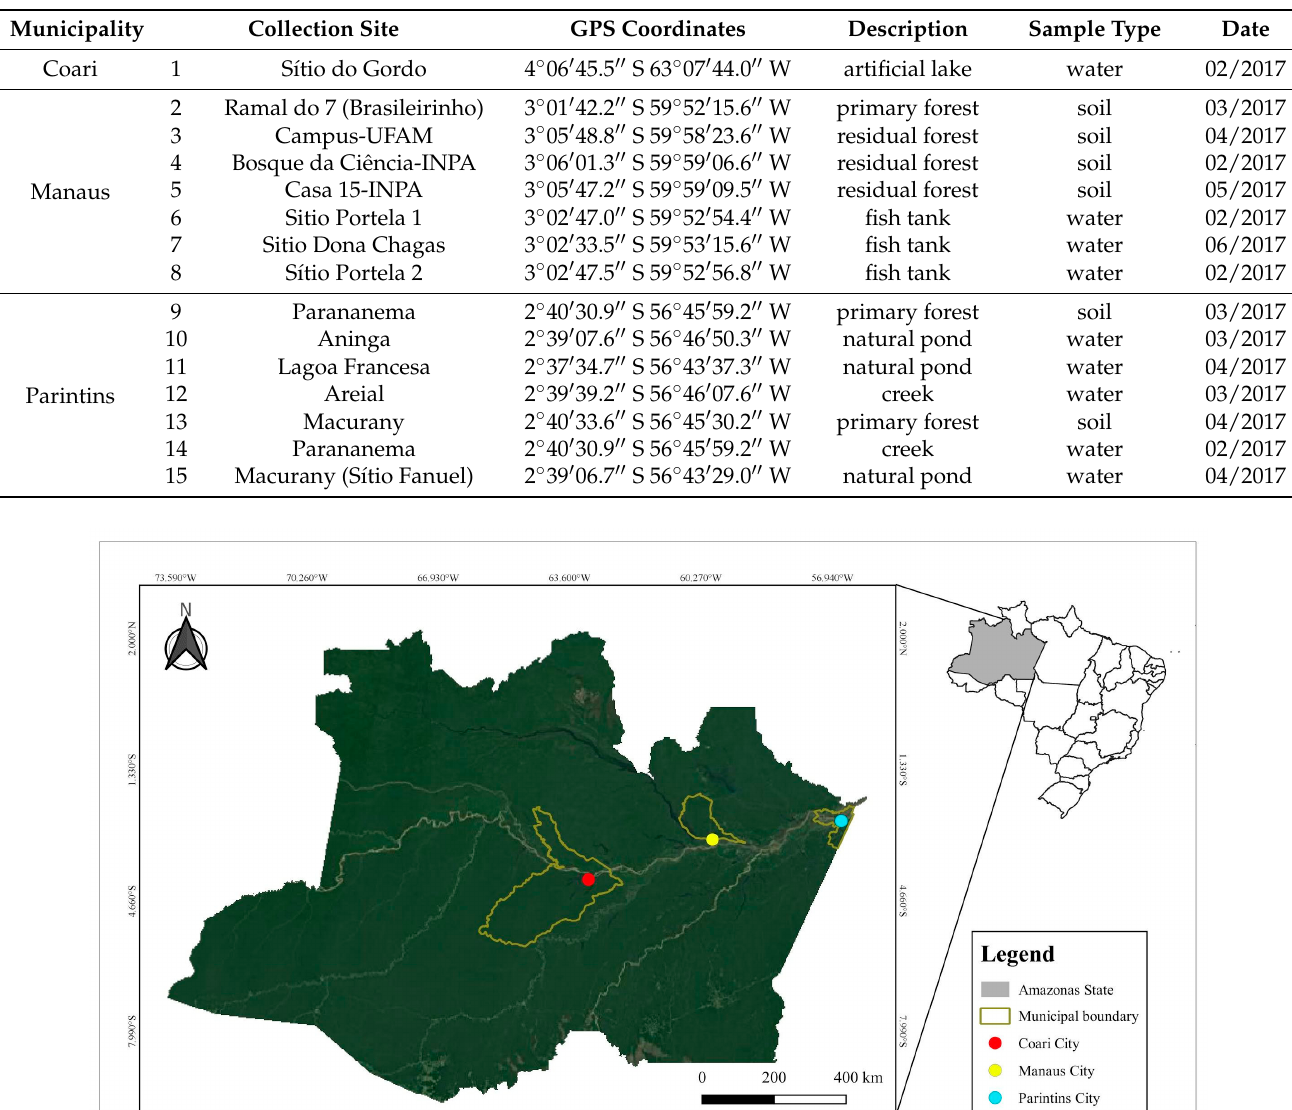
Table 1. Geographic location, date and characteristics of the 15 sites where water and soil were collected.